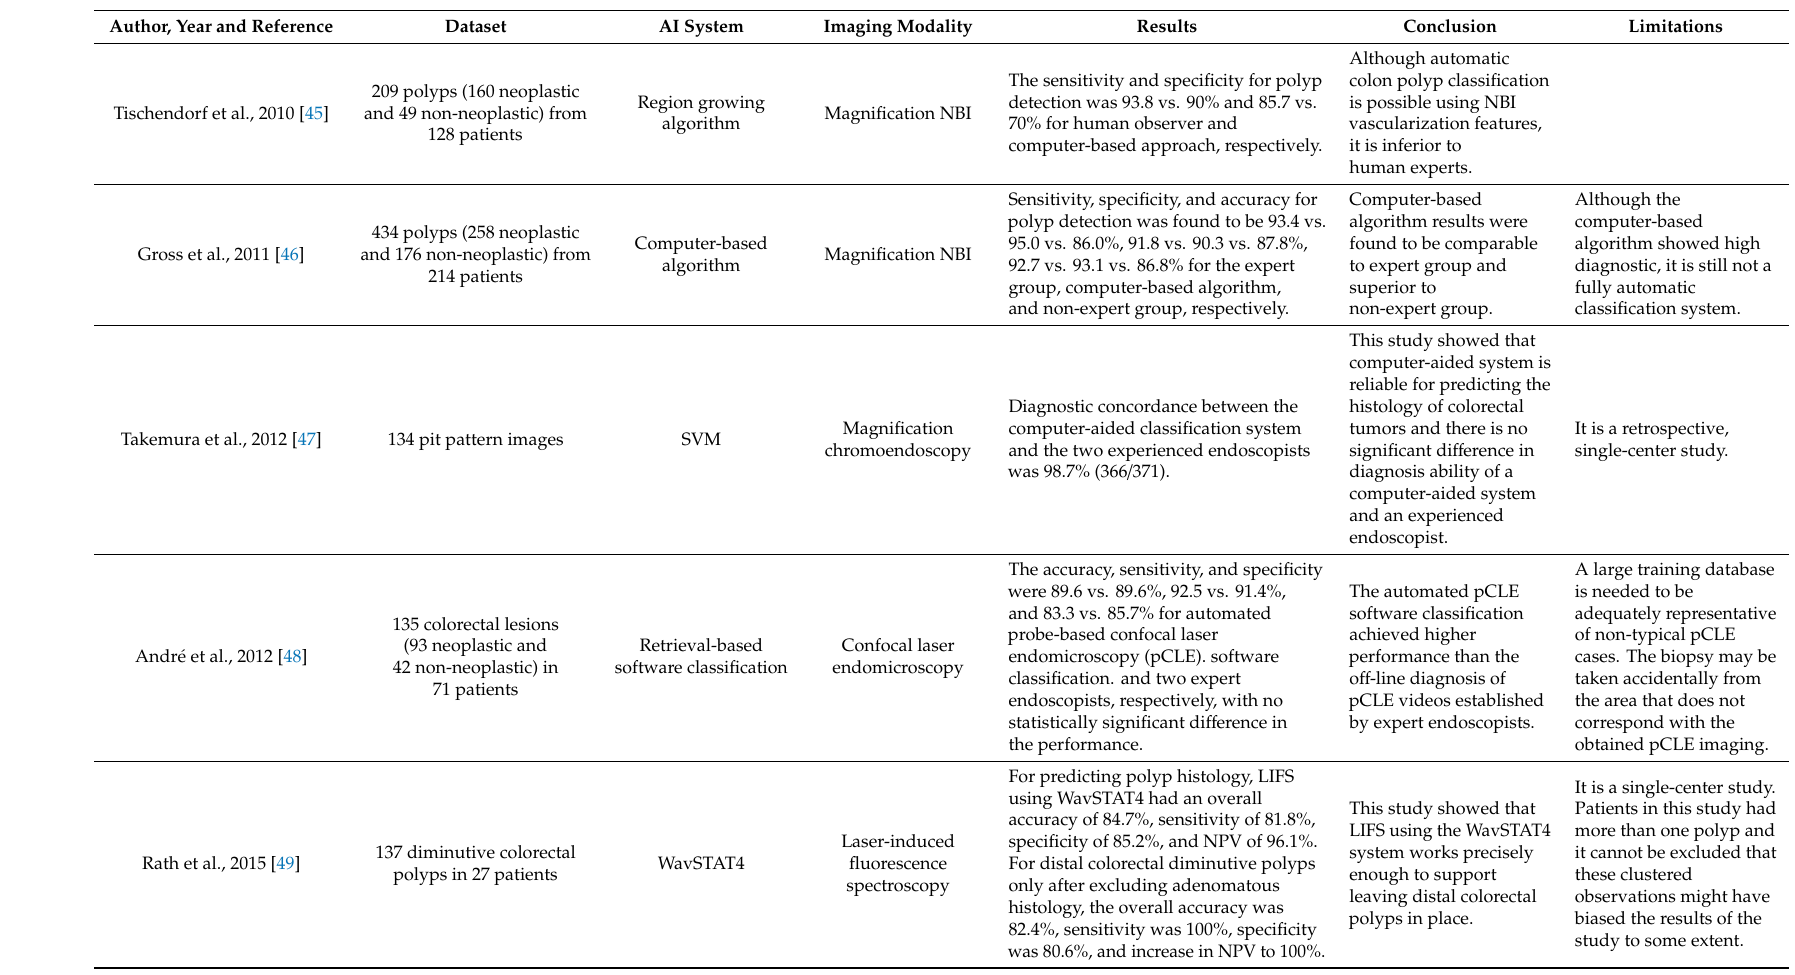
Table 2. Studies on AI in polyp